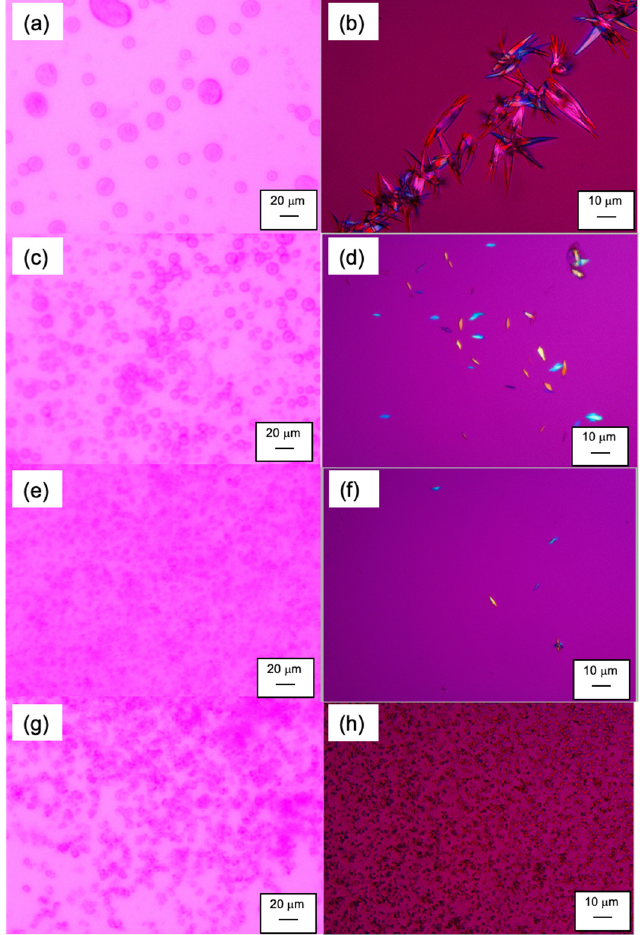
Figure 3. PLM images of LLPS and crystallization from supersaturated NFT solutions: ( a ) w/o polymer, 1 h after mixing; ( b ) w/o polymer, 4 h after mixing; ( c ) w/0.1% PVPVA, 1 h after mixing; ( d ) w/0.1% PVPVA, 4 h after mixing; ( e ) w/0.1% HPMCAS, 1 h after mixing; ( f ) w/0.1% HPMCAS, 4 h after mixing; ( g ) w/0.1% Eudragit, 1 h after mixing; ( h ) w/Eudragit, 4 h after mixing.